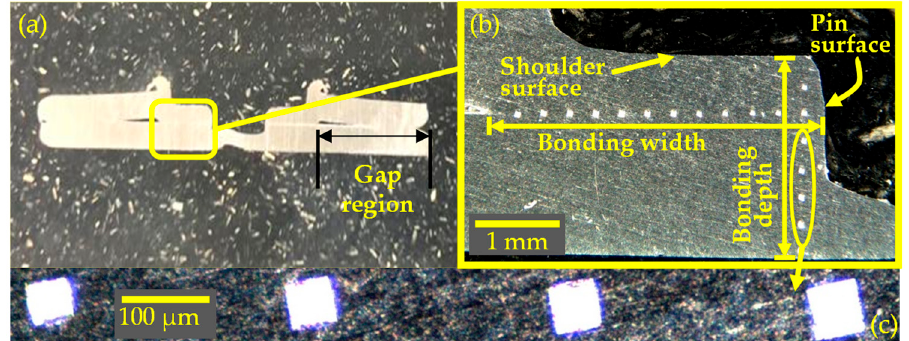
Figure 12. Microhardness measurements: ( a ) Cross-section of the weld showing the weld joint region and the region beyond the weld joint (gap region), ( b ) an example of the microhardness measurements along the bonding width and depth directions; ( c ) zoomed-in view of the microhardness indentations.